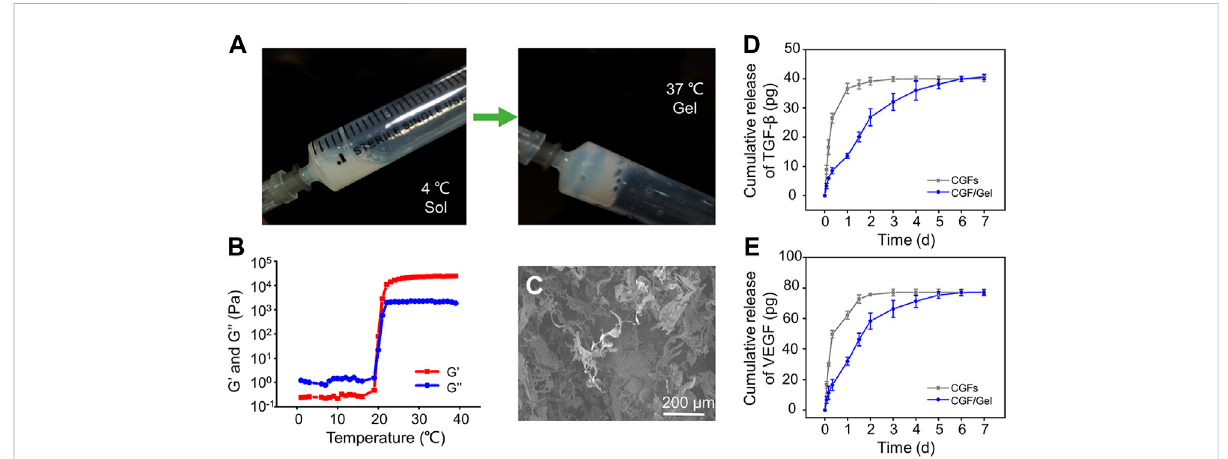
FIGURE 1 (A) Thegrossimagesofthesol-geltransitionprogress. (B) Rheometerdetectsthestoragemodulus(G ′ )andlossmodulus(G ″